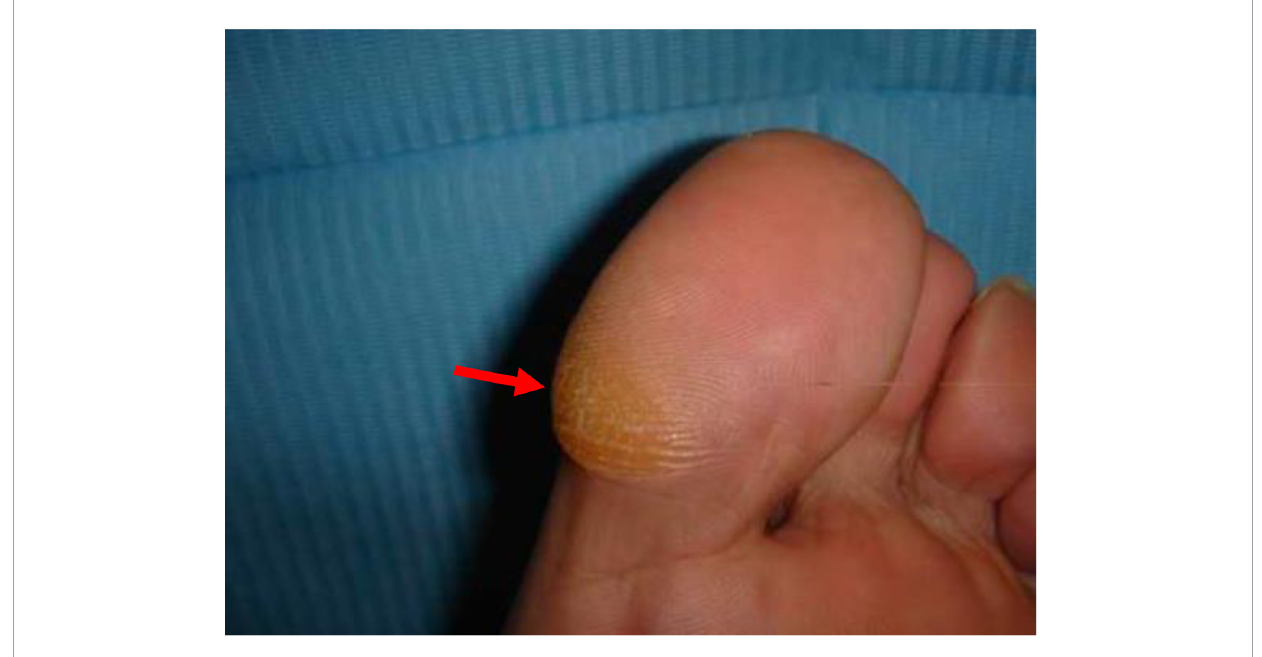
FIGURE2 Hyperkeratosis in interphalangeal joint (IPJ).